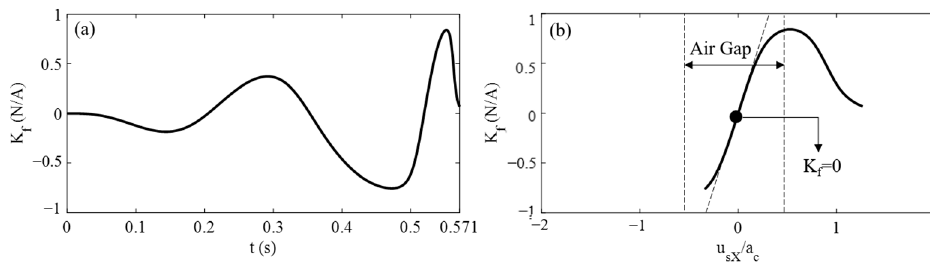
Figure 7. Variation of the electromechanical coupling coefficient with ( a ) time and ( b ) displacement of the coil.